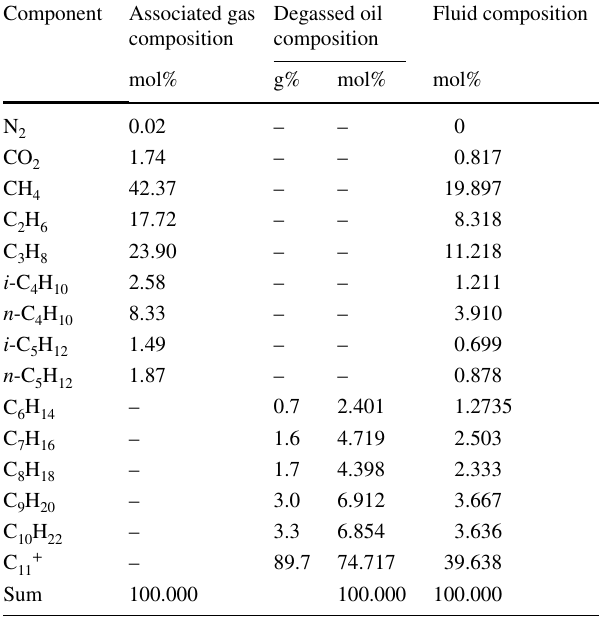
Table 1 Fluid composition of experiment